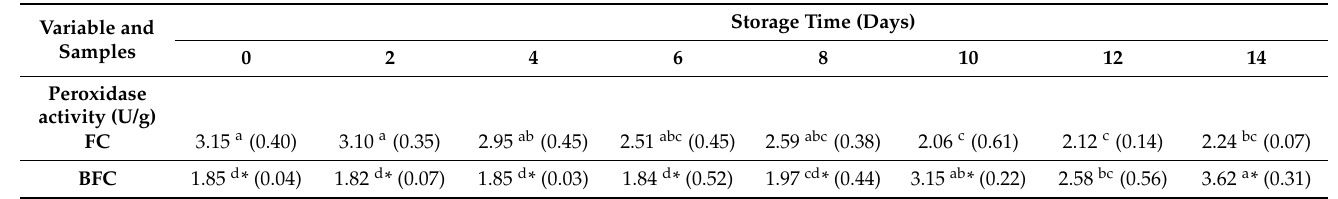
Table 2. Effect of blanching on the peroxidase enzymatic activity (U/g) during the refrigeration storage period of fresh cowpeas (FC) and blanched fresh cowpeas